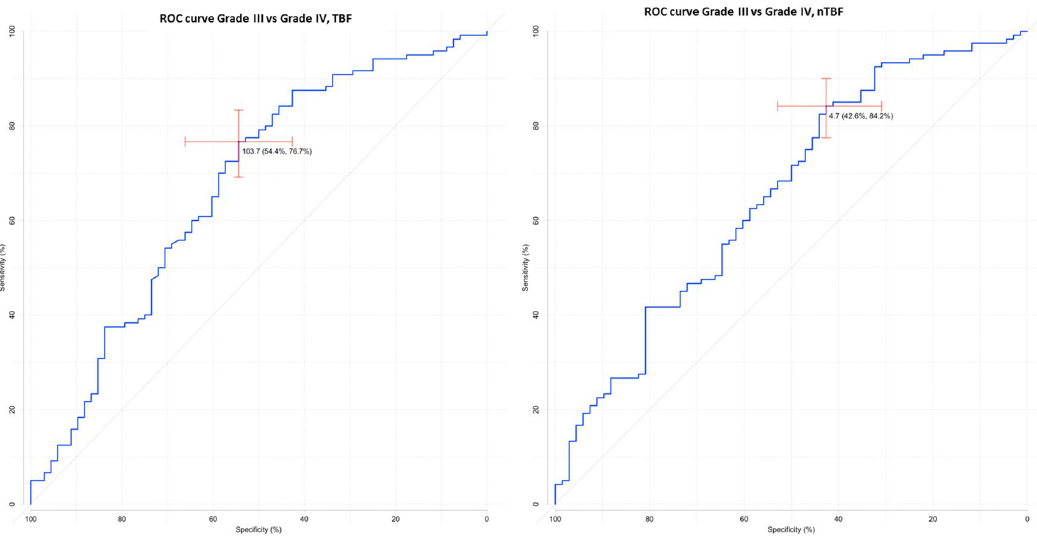
Figure 2. ROC-curve. Comparisons of maxTBF ( a ) and nTBF ( b ) in Grade III and Grade IV